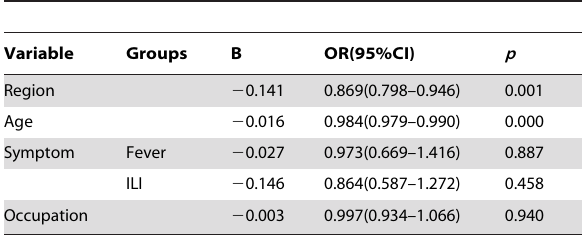
Table 3. Multivariate Logistic Regression Model Predicting risk factors for 2009 H1N1